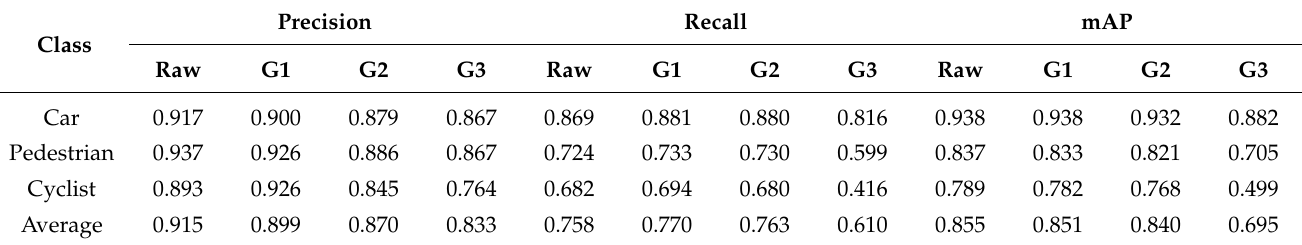
Table 5. Evaluation metrics for KITTI point cloud data compressed at different degrees, converted with the Bilateral Filter method and evaluated using the best YOLOv5l model. The resulting model, with the best weights, was obtained over the course of 200 epochs using a batch size of 10.